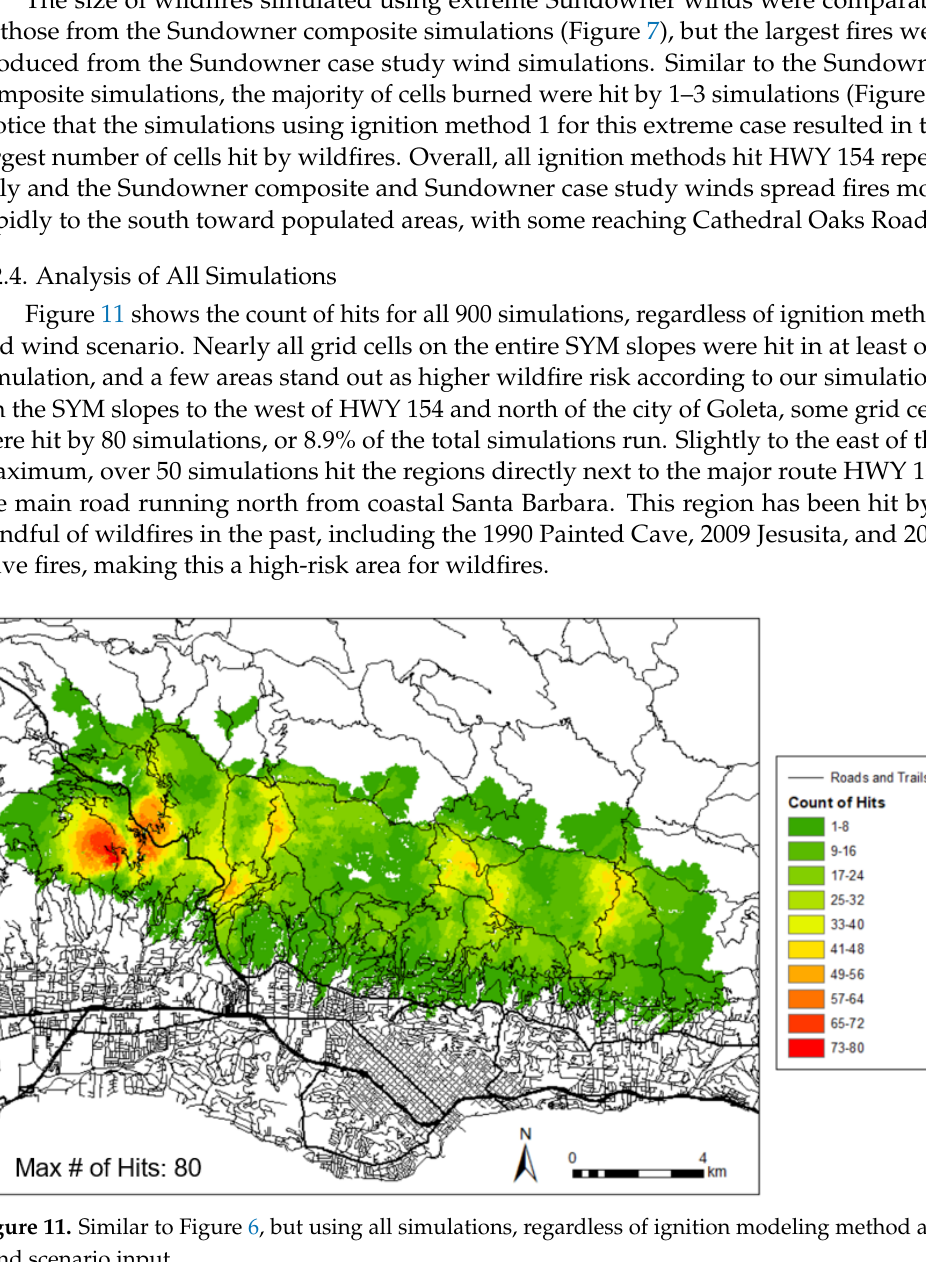
Figure 11. Similar to Figure 6, but using all simulations, regardless of ignition modeling method and wind scenario input. wind scenario